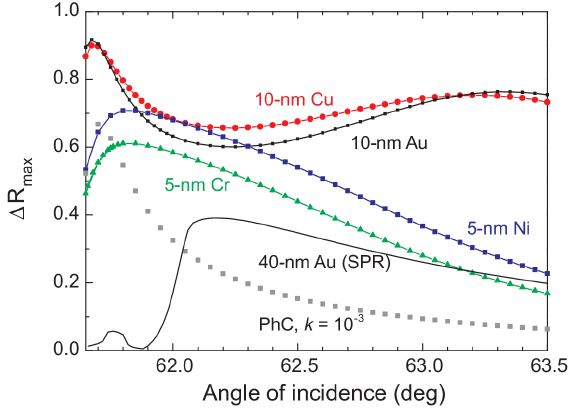
Figure 5. Maximum response of PPhC-based sensors made of different metals versus the angle of incidence [(Ta 2 O 5 /SiO 2 ) 10 /metal/SiO 2 ]. For reference, the black line shows the response of an SPR sensor (single 40-nm-thick Au film) and the squares illustrate the response of an (Ta 2 O 5 /SiO 2 ) 10 multilayer-based SWR sensor with absorption of k = 1 × 10 − 3 homogeneously introduced into each layer.